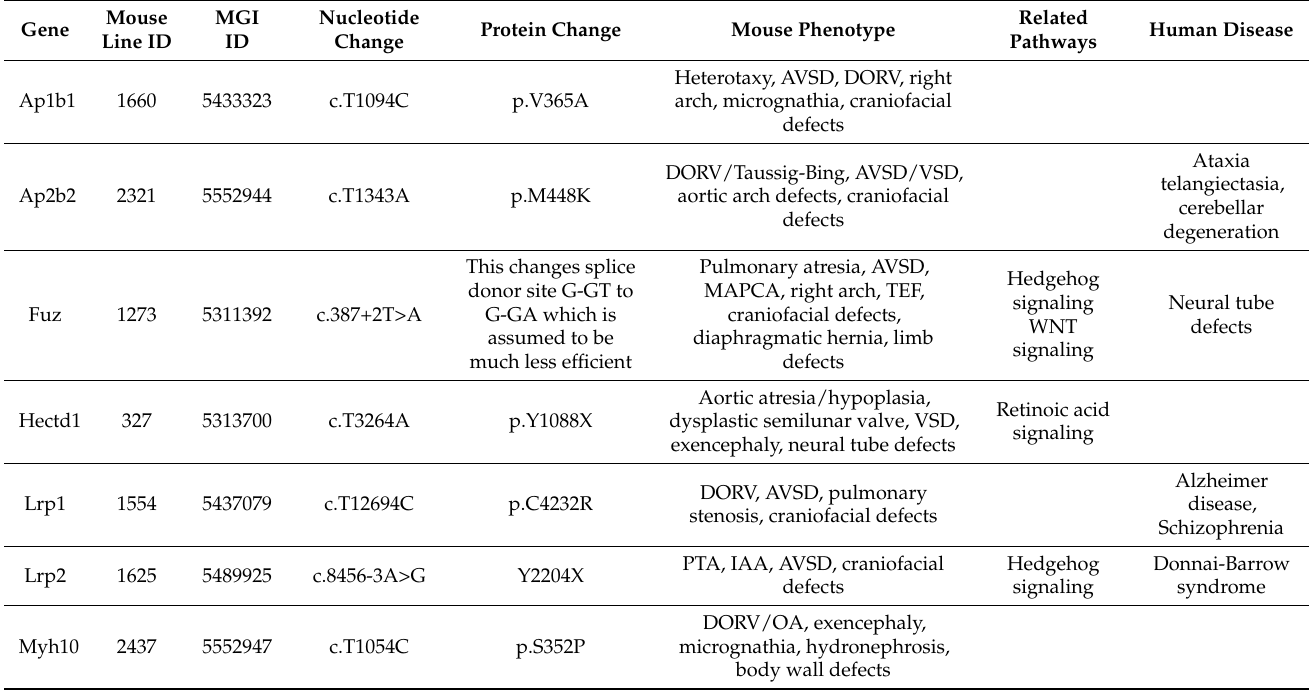
AVSD: atrioventricular septal defect, DORV: double outlet of right ventricle, IAA: interrupted aortic arch, MAPCA: Major aortopulmonary collateral arteries, OA: overriding of aorta, PTA: persistent truncus arteriosus, TEF: tracheoesophageal fistula, VSD: ventricular septal